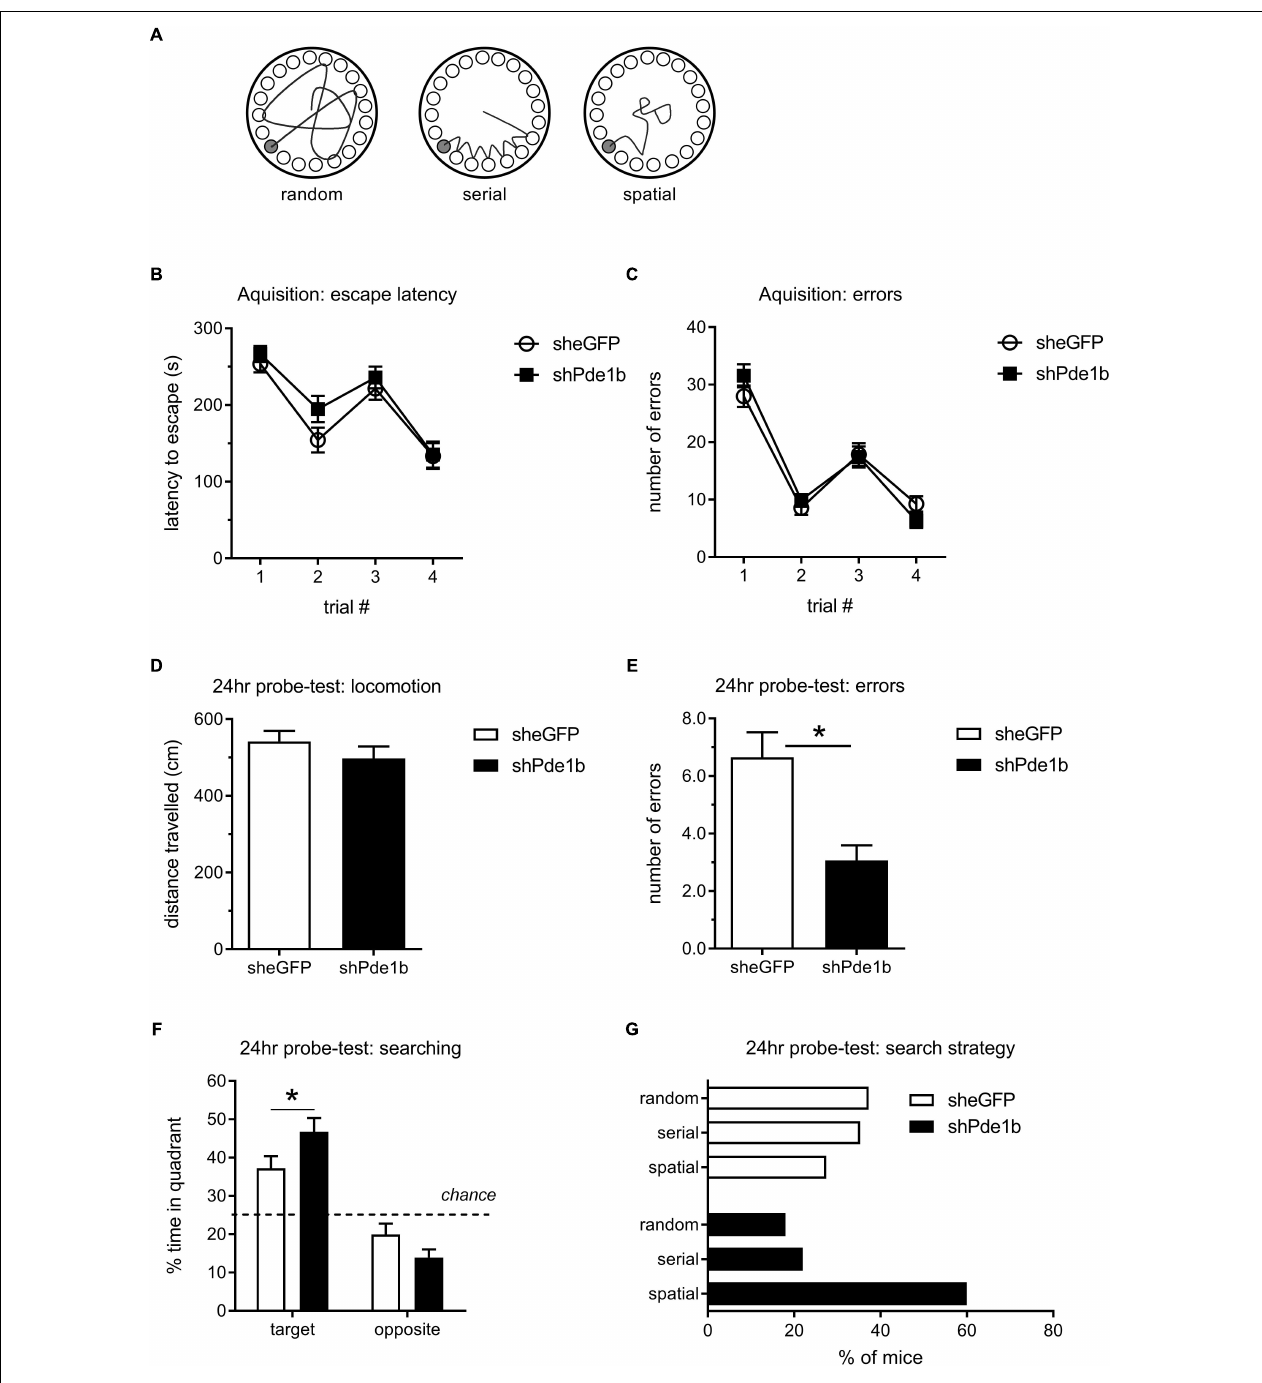
FIGURE 2 | Effects of intra-hippocampal shRNA PDE1B knockdown on spatial memory in the Barnes Maze in mice. (A) Search strategies employed in the Barnes Maze test. Mice randomly sample escape holes first, but then quickly revert to serial sampling and finally employ spatial search strategies as training progresses. (B) Escape latencies during the 4 acquisition trials, two each day separated by a 1 min ITI, did not differ between the treatment groups. (C) The number of errors prior to the correct escape did not differ amongst the treatment groups. Both shPde1b ( n = 50) and shGFP control ( n = 51) virus treated mice improved within each training day, indicating normal working memory. D-G) A 2 min probe-test was conducted 24 h after the 4th acquisition trial. (D) Locomotion during probe-test did not differ between the treatment groups. (E) shPde1b treated mice made significantly less errors before approaching the correct (trained) escape hole. (F) shPde1b mice spent significantly more time in the quadrant that contained the trained escape hole than shGFP controls. (G) Proportion of mice using random, serial, and spatial sampling strategies. A larger proportion of shPde1b treated mice utilized spatial search strategies. Mean ± s.e.m. are shown. Significant differences from vehicle control are indicated by an asterisk ( ∗